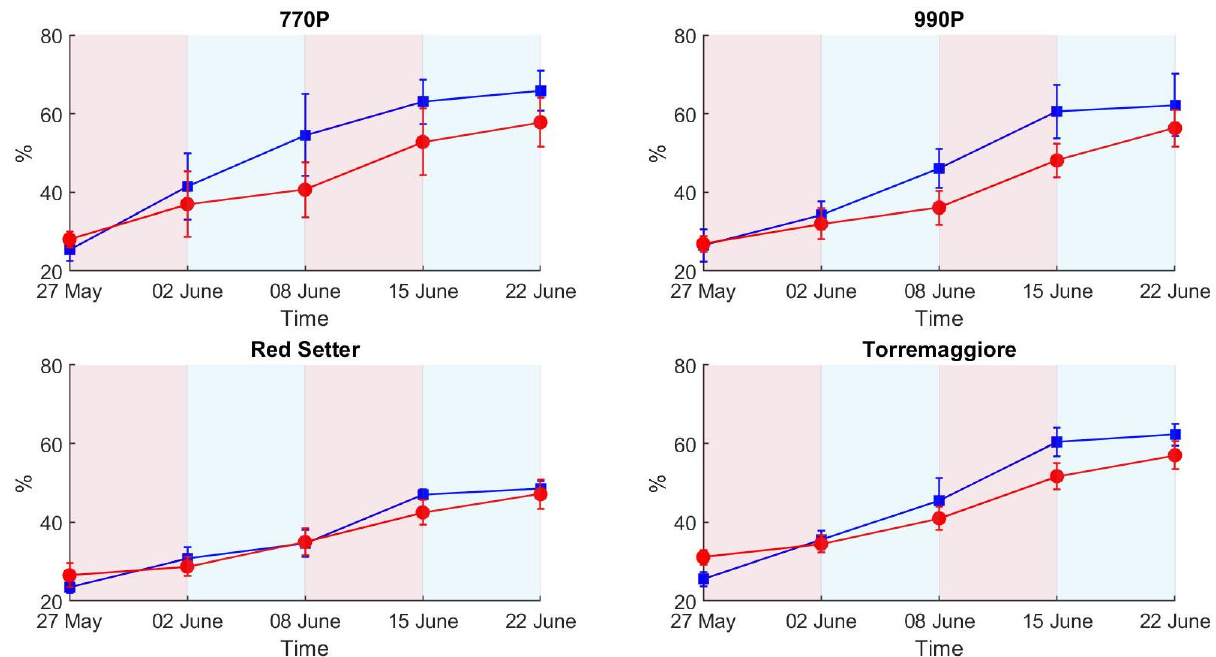
Figure 8. Senescence index values in stressed and control treatments (red and blue lines and points, respectively) for the four genotypes. Each point reports the mean of six samples and the associated standard deviation.